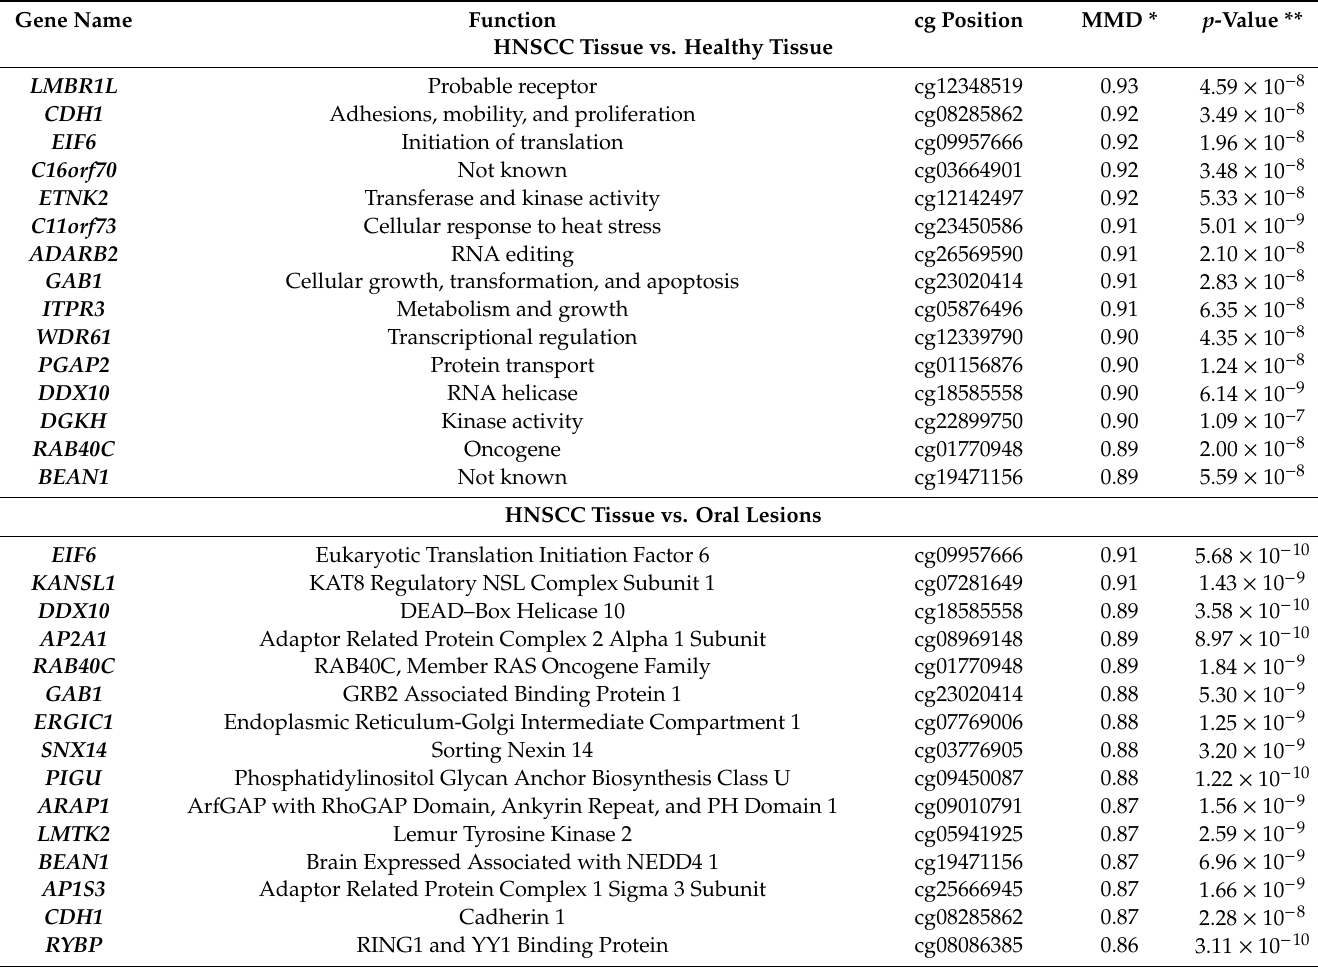
Table 3. Hypermethylated 5 (cid:48) -cytosine-phosphate-guanine-3 (cid:48) (CpG) sites methylation in HNSCC tissue compared to control healthy tissue and potentially premalignant oral lesions, and in potentially premalignant oral lesions compared to control healthy tissue. The list is merged of top fifteen di ff erentially methylated genes according to the extent of methylation di ff erence